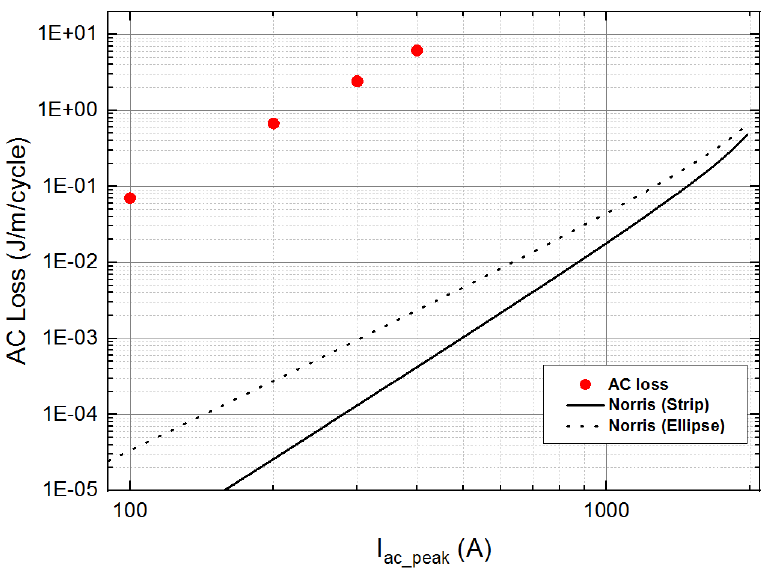
Figure 10. Corresponding to Figure 9, losses in the HTS magnet with pure 50 Hz AC sinusoidal currents of 100, 200, 300, and 400 A (peak) converted into the unit of Joule/cycle/m. When the superconducting maglev suffers some instability (e.g., fluctuations of the power supply), the transport current in the HTS magnet is not pure DC but with some small AC components (e.g., ripples). Figure 11 shows the losses in the HTS magnet with a 360 A DC current and 50 Hz AC sinusoidal ripple currents of 10, 30, and 50 A. From 0 s to 0.1 s, before the ripples start, the loss is 0 as expected for all the cases. From 0.1 s to 0.2 s, five cycles of sinusoidal ripples correspond to five peaks of loss curves, and the first rip- ple losses reach the peak loss points and then attenuate. For the 50 A ripple cases, the peak loss reaches approximately 70 W/m. It can be seen that the ripple currents can also cause a considerable amount of losses. This kind of instability AC loss will result in the form of heat dissipation, and the Maglev cryogenic system should cope with this level of